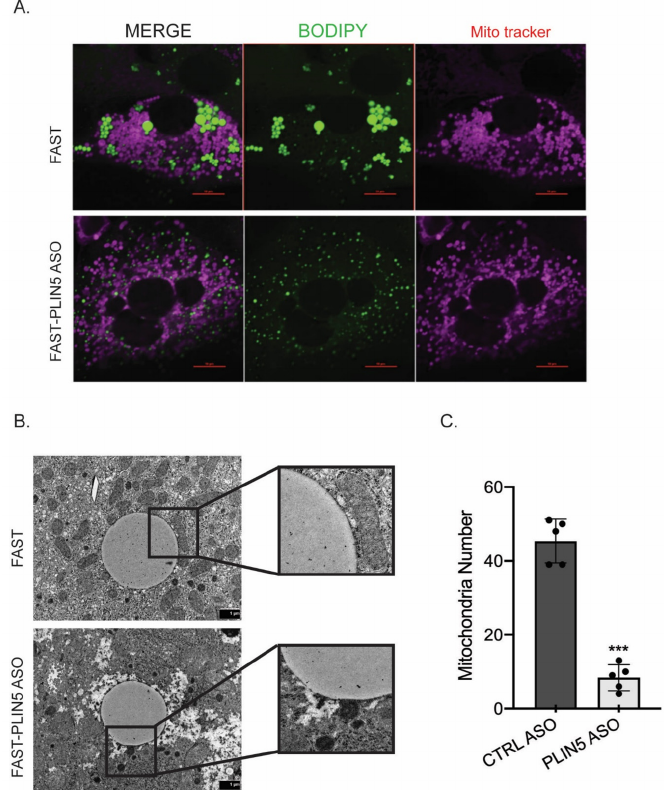
Figure 3. The role of mitochondria in lipid droplets formation is dependent on PLIN5. ( A ) Confocal imaging of primary mouse hepatocytes incubated with BODIPY-LD (green) and MitoTracker (purple). Scale bars: 10 μ m. ( B ) Electron microscopic images of hepatocellular LDs and mitochondria. Scale bars: 1 μ m. ( C ) Quantitative analysis of the number of mitochondria in CTRL ASO and PLIN5 ASO cells. *** p < 0.001 vs. CTRL ASO.